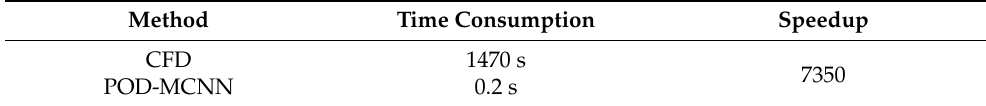
Table 5. Model time speedup performance.